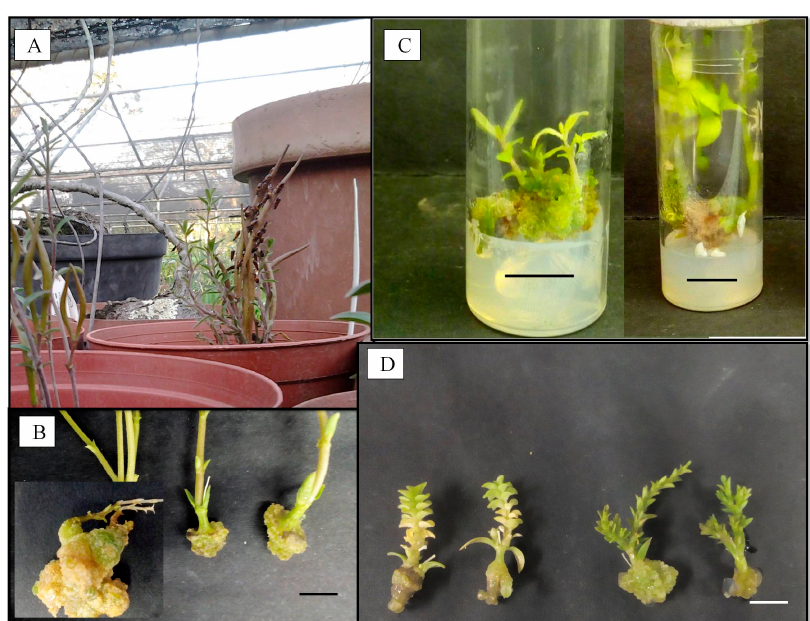
Figure A2. Observations during explant decontamination and bulking up of plant material. ( A ) Aphids feeding on Brachystelma pygmaeum fruit, contributing to contamination. ( B ) Callus formed from nodal explants (callus also gave rise to adventitious shoots). ( C ) Hyperhydric shoots derived from Brachystelma pygmaeum callus cultures on Murashige and Skoog (MS) medium without plant growth regulators. ( D ) Morphological abnormality of Brachystelma grown in vitro. Scale bar = 10 mm.